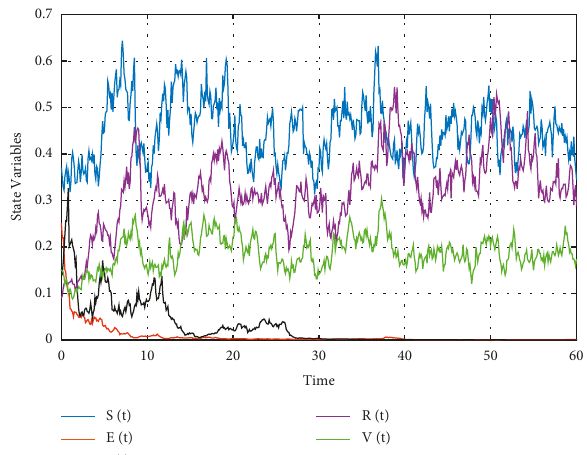
Figure 4: Numerical simulations of model (4) shows that the disease dies out when the white noise is relatively large such that 􏽢 R